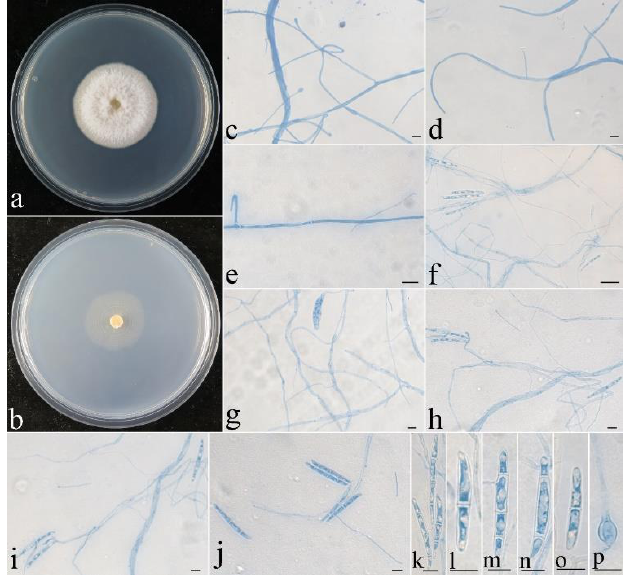
Figure 11. Colonial and microscopic morphology of Thelonectria spinulospora (CGMCC 3.24133). ( a ) Colony after 2 week at 25 °C on PDA; ( b ) colony after 2 week at 25 °C on SNA; ( c – e ) conidiophores in lactophenol cotton blue; ( f – j ) conidiophores and macroconidia in lactophenol cotton blue; ( k – o ) macroconidia in lactophenol cotton blue; ( p ) chlamydospore in lactophenol cotton blue. Bars: ( c – p ) = 10 μm.